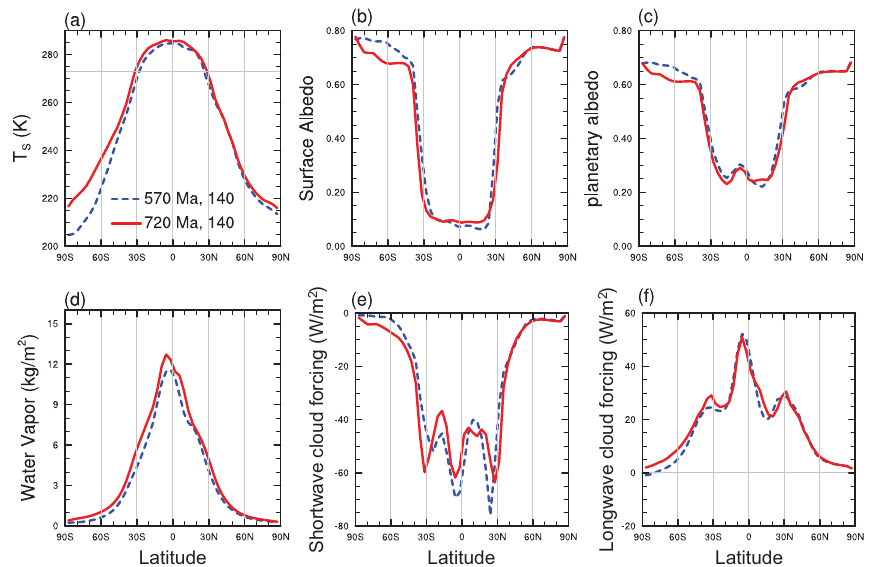
Fig. 10. Comparison of zonal mean surface temperature, surface albedo, planetary albedo, water vapor in the atmospheric column, short- wave and longwave cloud forcing between the two continental configurations. TSI = 0.94TSI 0 , p CO 2 = 140 ppmv and τ = 0 . 12 for both simulations. The results are from hundred-year averages of the simulations at